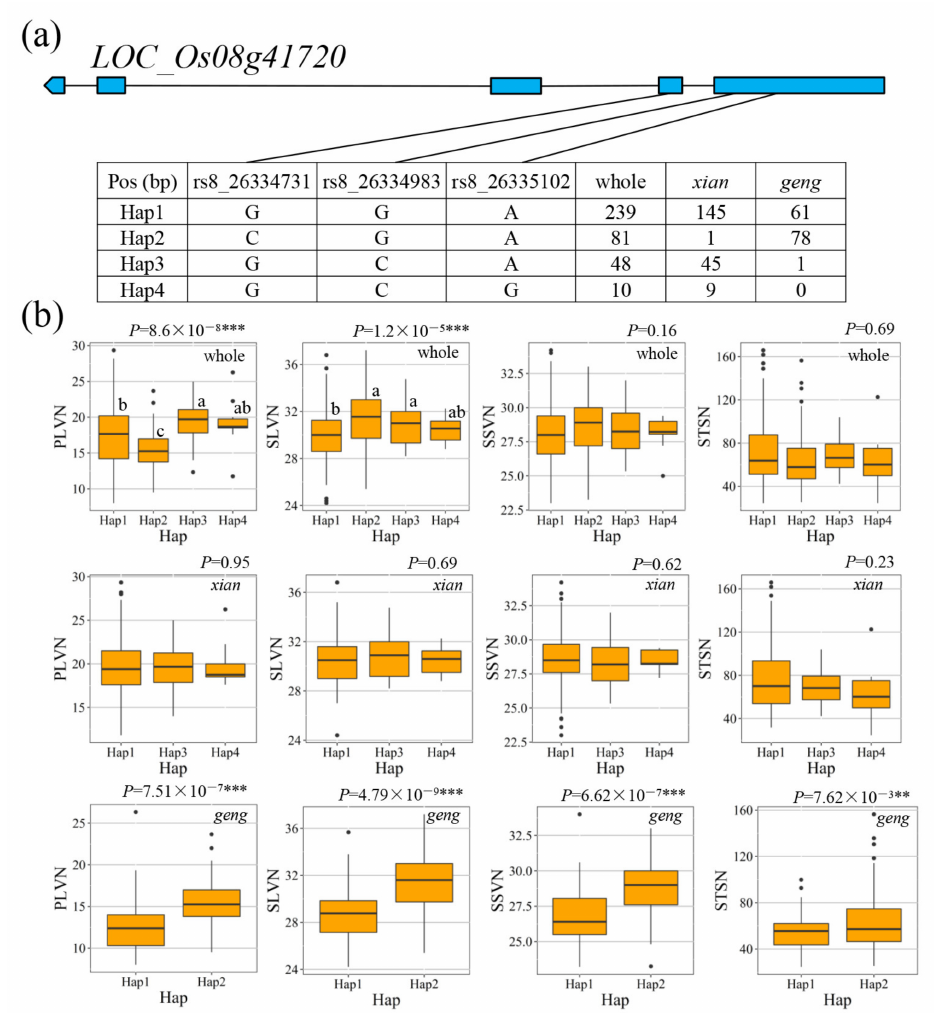
Figure 8. Haplotype analysis of the LOC_Os08g41720 candidate gene for PLVN, SLVN, SSVN, and STSN at qPLVN8 , qSLVN8 , qSSVN8 , and qSTSN8.2 . ( a ) Exon-intron structure of LOC_Os01g41720 and DNA polymorphism in that gene. ( b ) Boxplots for PLVN, SLVN, SSVN, and STSN based on the haplotypes (Hap) for LOC_Os01g41720 in the whole, xian, and geng populations. ** and *** represent significance of ANOVA at p < 0.01 and p < 0.001, respectively. Letters on the histogram (a and b) are ranked by Duncan’s test at p < 0.05. PLVN: number of large vascular bundles in panicle neck; SLVN: number of large vascular bundles in second internode; SSVN: number of small vascular bundles in second internode; STSN: total spikelets number on secondary rachis